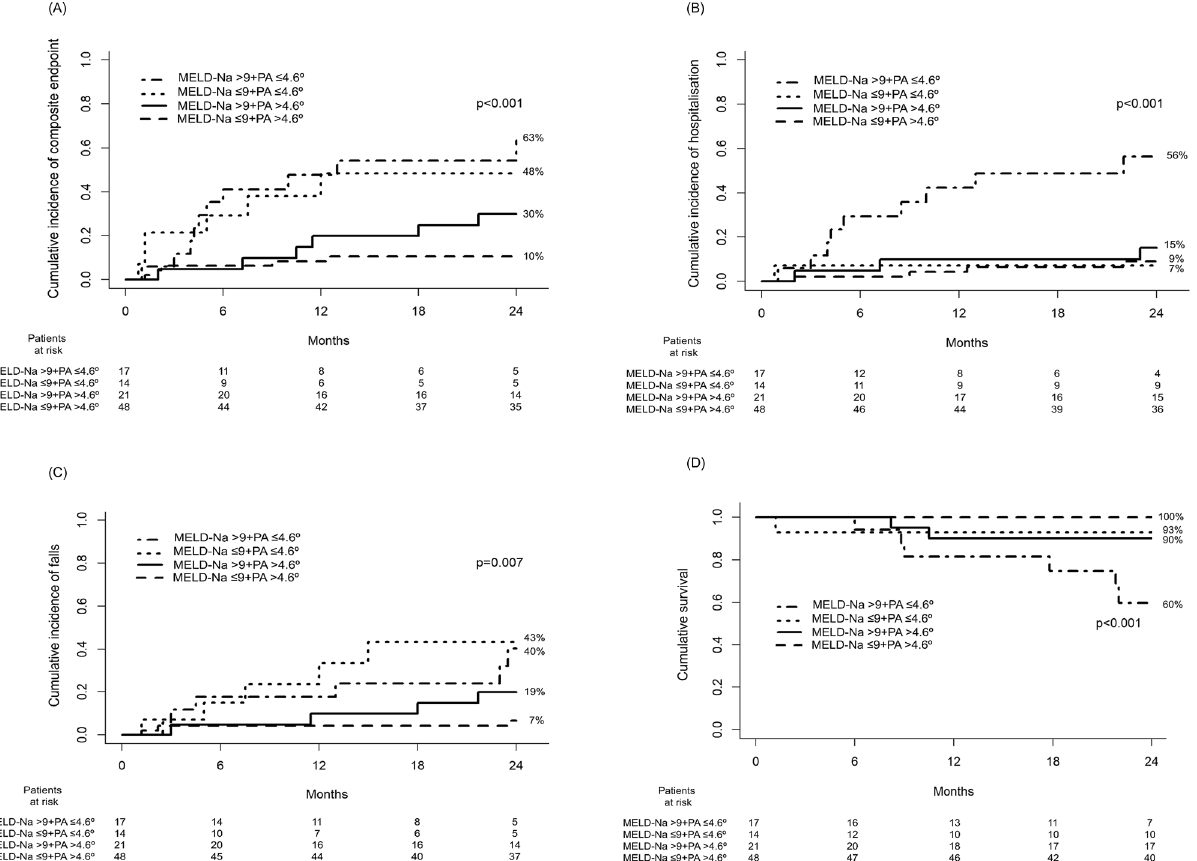
Figure 3. Probability of the composite endpoint (hospitalisation, admission to a long-term care centre, falls, or mortality) (A) , hospitalisation (B) and falls (C) , and survival (D) at 2-year follow-up classifying patients according to MELD-Na score ≤ or > 9 and phase angle (PA) ≤ or >